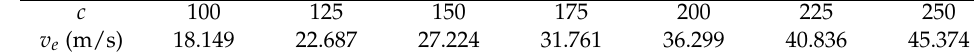
Table 4. Erosional velocity range for pipeline flow of natural gas at 60 bar, 303.15 K.